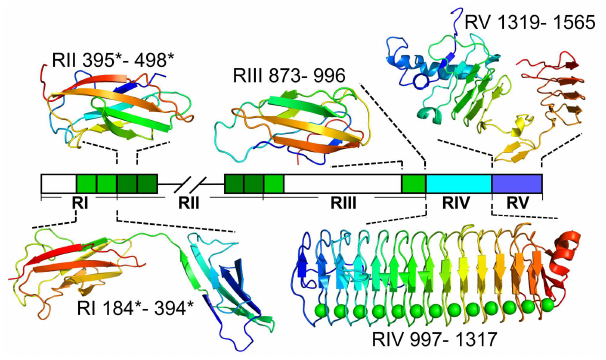
Figure 6. Homology models produced for domains of Mp AFP using Phyre2. The linear map of the regions of Mp AFP is colored as in Fig. 3. Hatched lines indicate the break between the two contiguously sequenced segments of Mp AFP. Uncolored regions could only be modeled ab initio by the Phyre2 server and did not produce reliable results. Colored regions were modeled at greater than 90% confidence and their structures in ribbon representation are shown above and below the map of Mp AFP. The X-ray crystal structure of RIV is shown [9]. Residues for each model/structure are numbered according to the sequence in Fig. 3. The protein folds are shown in the colors of the rainbow from the N terminus (blue) to the C terminus (red).